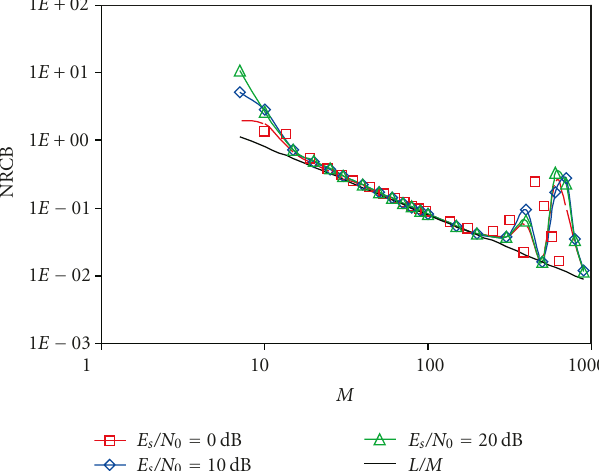
Figure 3: Influence of the number of pilots M on the GCRB, ν = 7, N = 1024.